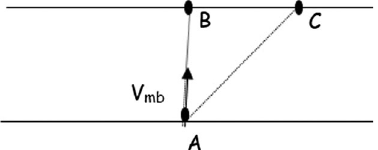
FIG. 3. Diagram accompanying the three-part homework ques- tion